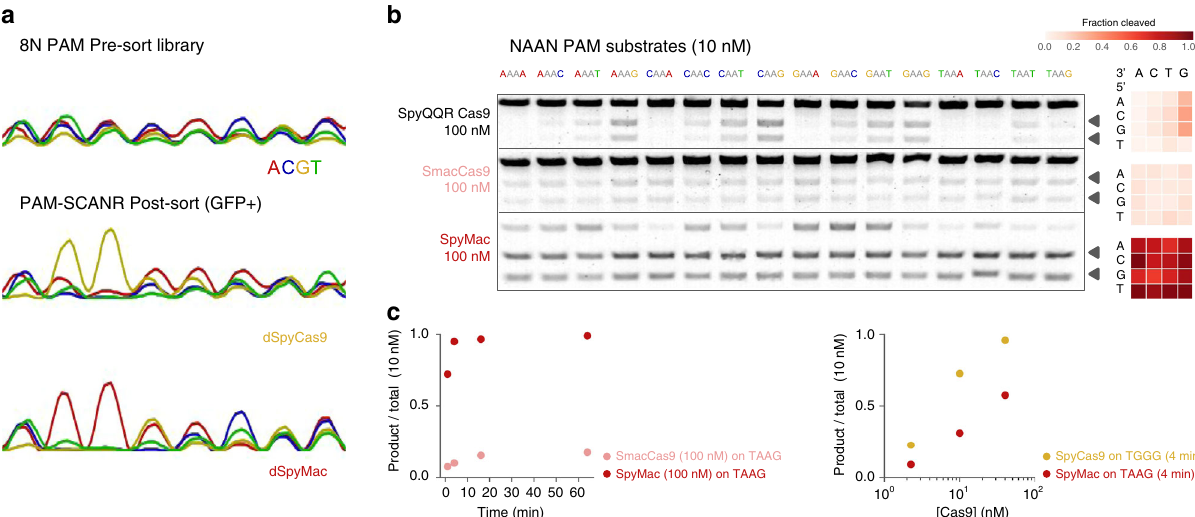
Fig. 2 Validation of SmacCas9 recognition for adenine dinucleotide PAM sequences. a Chromatograms representing the PAM-SCANR based enrichment of variant-recognizing PAM sequences from a 5 0 -NNNNNNNN-3 0 library. b SYBR-stained agarose gels showing in vitro digestion of 10 nM 5 0 -NAAN-3 0 substrates upon 16 minutes of incubation with 100 nM of puri fi ed ribonucleoprotein enzyme assemblies. Arrows distinguish banding of the cleaved products from uncleaved substrate (top band). Matrix plots summarize cleaved fraction calculations, which were carried out in a custom script for processing gel images. Samples were performed in independent biological duplicates ( n = 2). c Time course measurements of target DNA substrate cleavage for SmacCas9 and SpyMac. d DNA substrate cleavage plotted as a function of 0.25:1, 1:1, and 4:1 molar ratios of ribonucleoprotein to target for wild-type SpyCas9 and hybrid SpyMac. Source data are provided as a Source Data fi